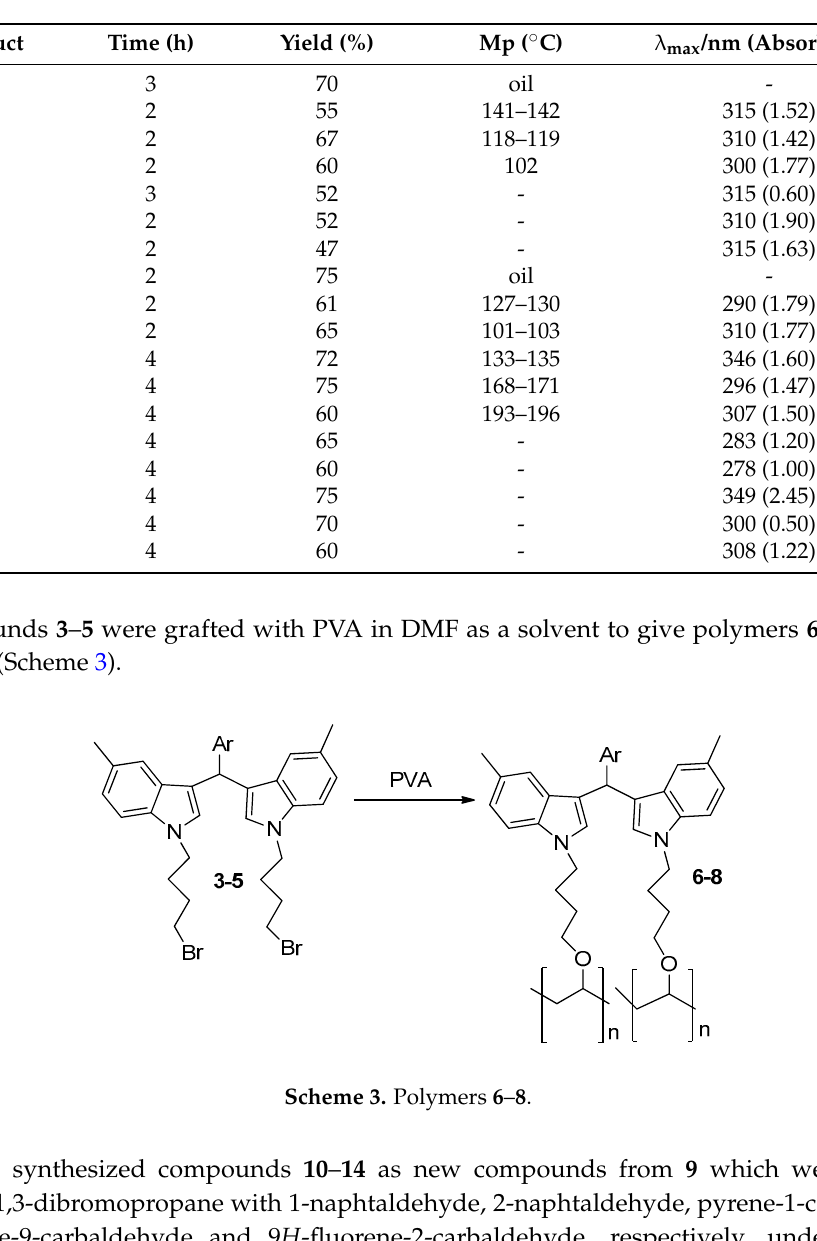
Table 1. Properties of new compounds.